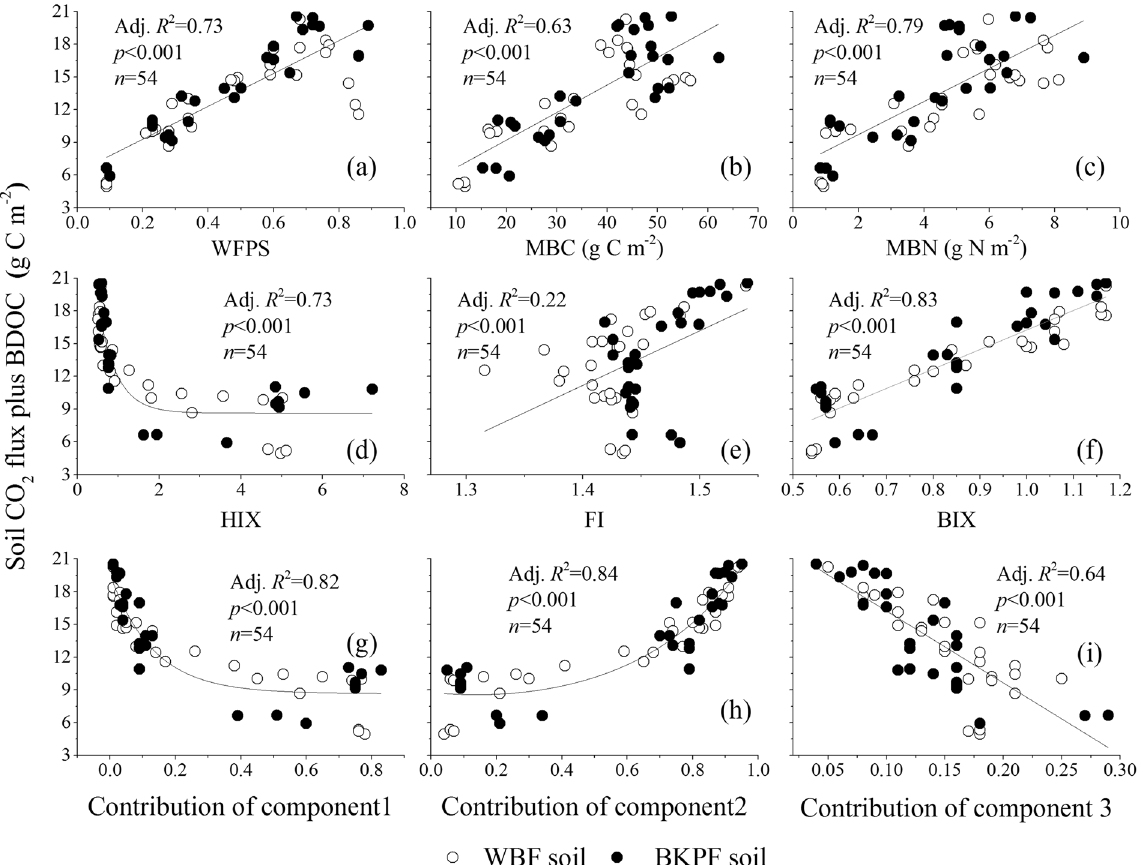
Figure 5. Relationships of the soil potential organic carbon decomposition (CO 2 flux plus BDOC) against the soil WFPS, microbial biomass, the contribution of three components and spectral properties of